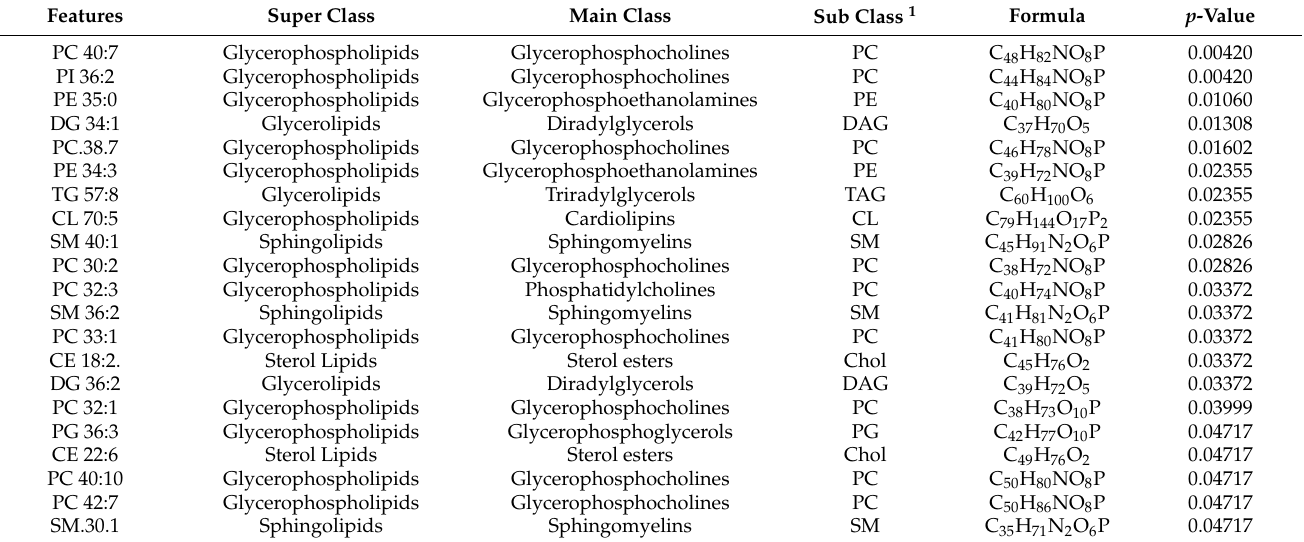
Table 4. Features selected by Mann–Whitney U test of the lipidomic profile in